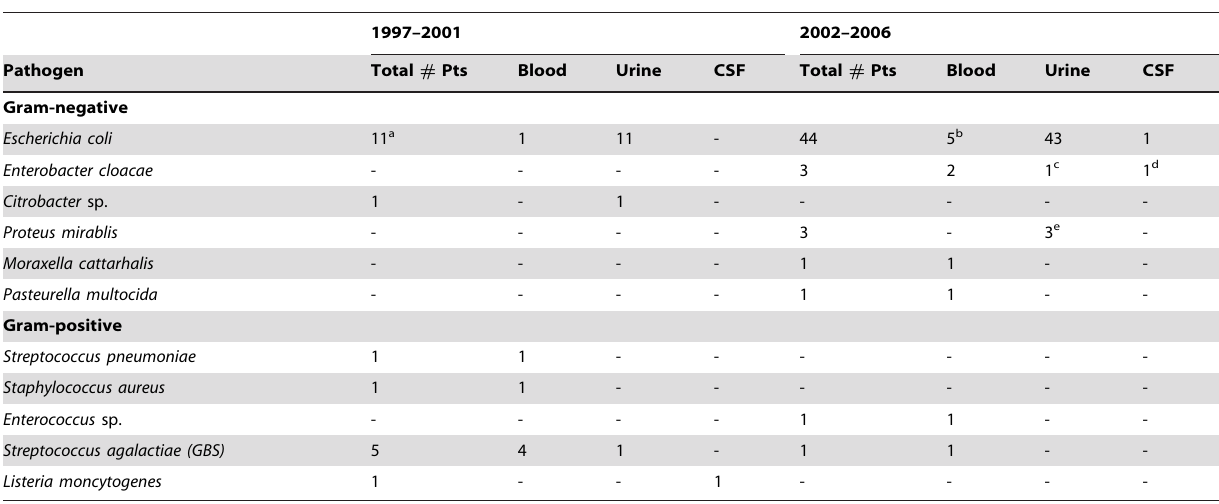
Table 3. Bacterial Pathogens by Species and Site of Infection.